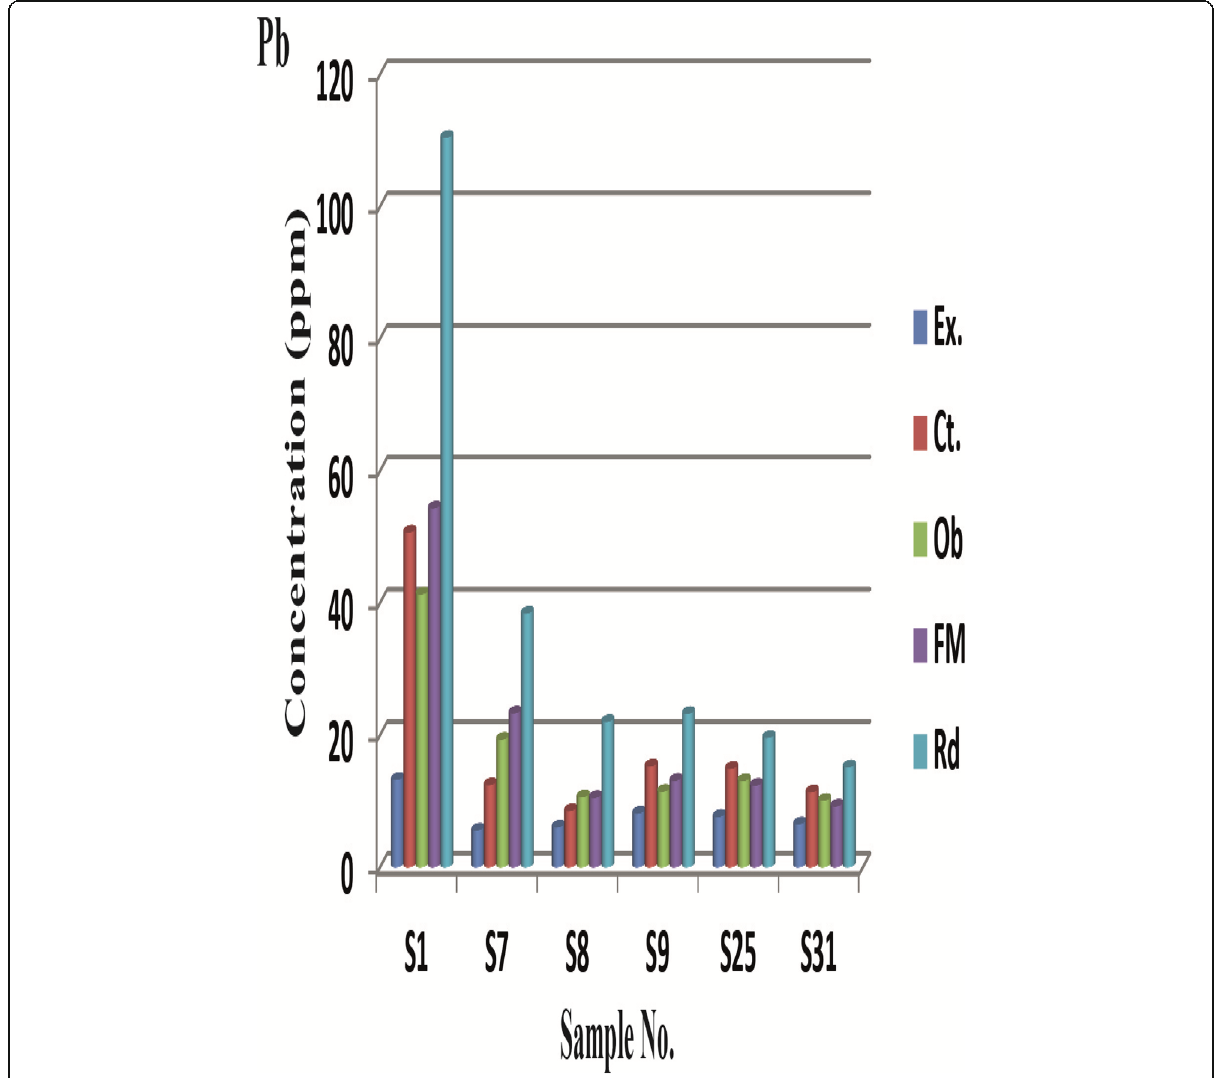
Fig. 6 Relative distribution of Pb among the various soil fractions in the study